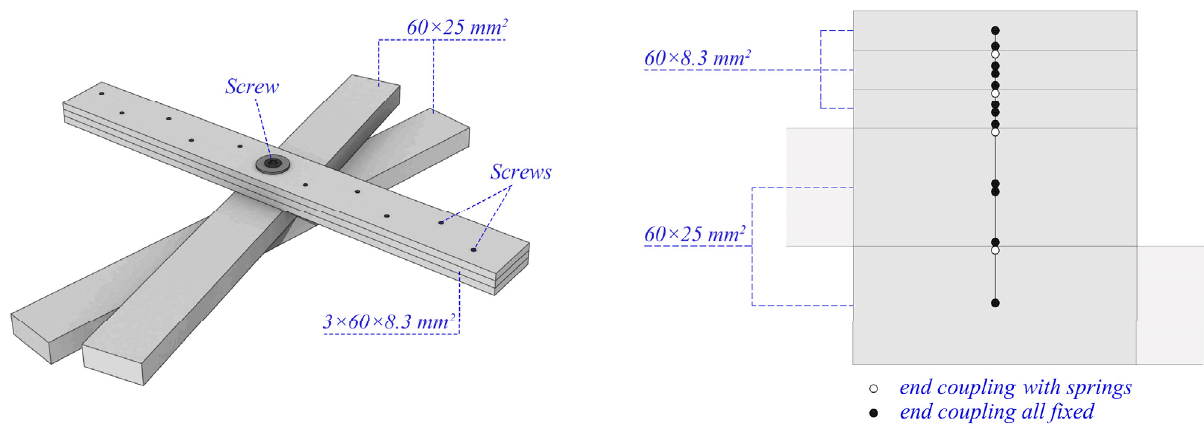
Figure 8. Joint Type 1 . Layout detail and aligned couplings for the numerical model.